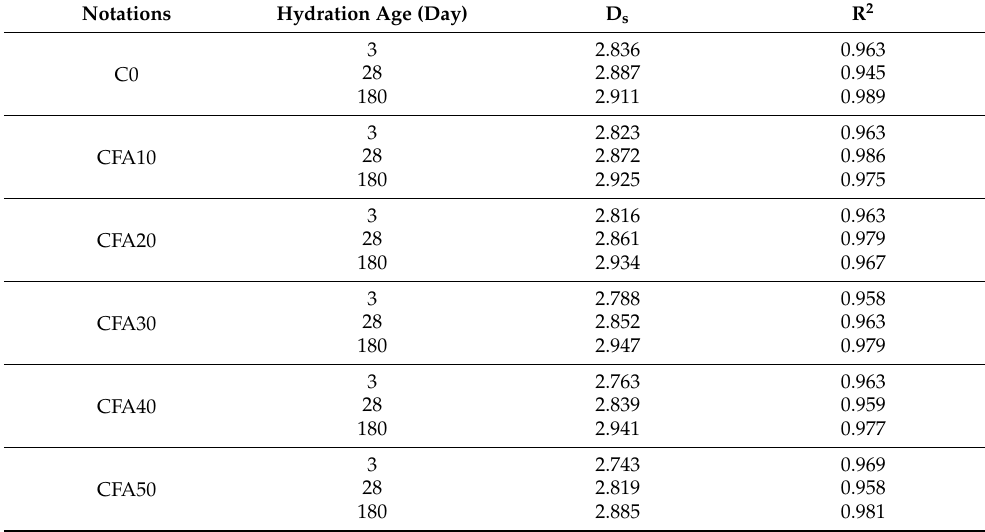
Table 5. D s of the face slab concretes containing fly ash at different